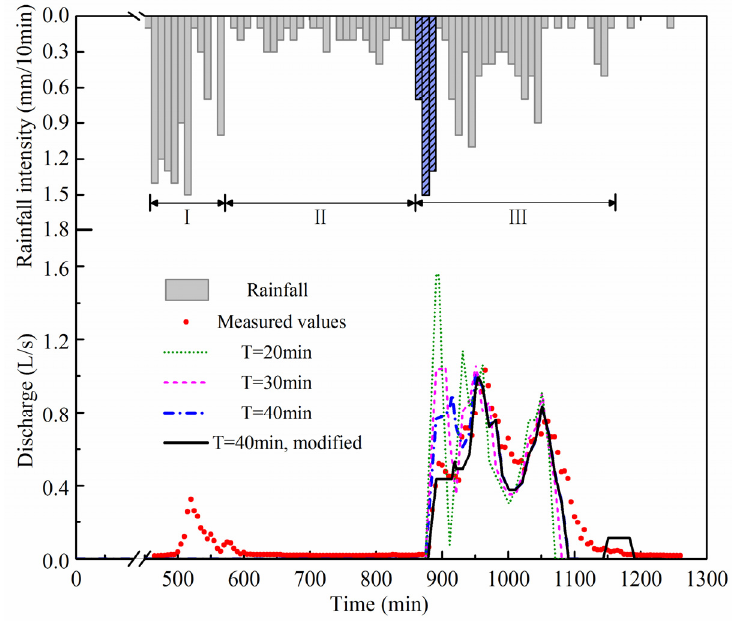
Figure 9. Observed and simulated hydrographs of unified topography cases of different concentration times in 20160406 rainfall event.